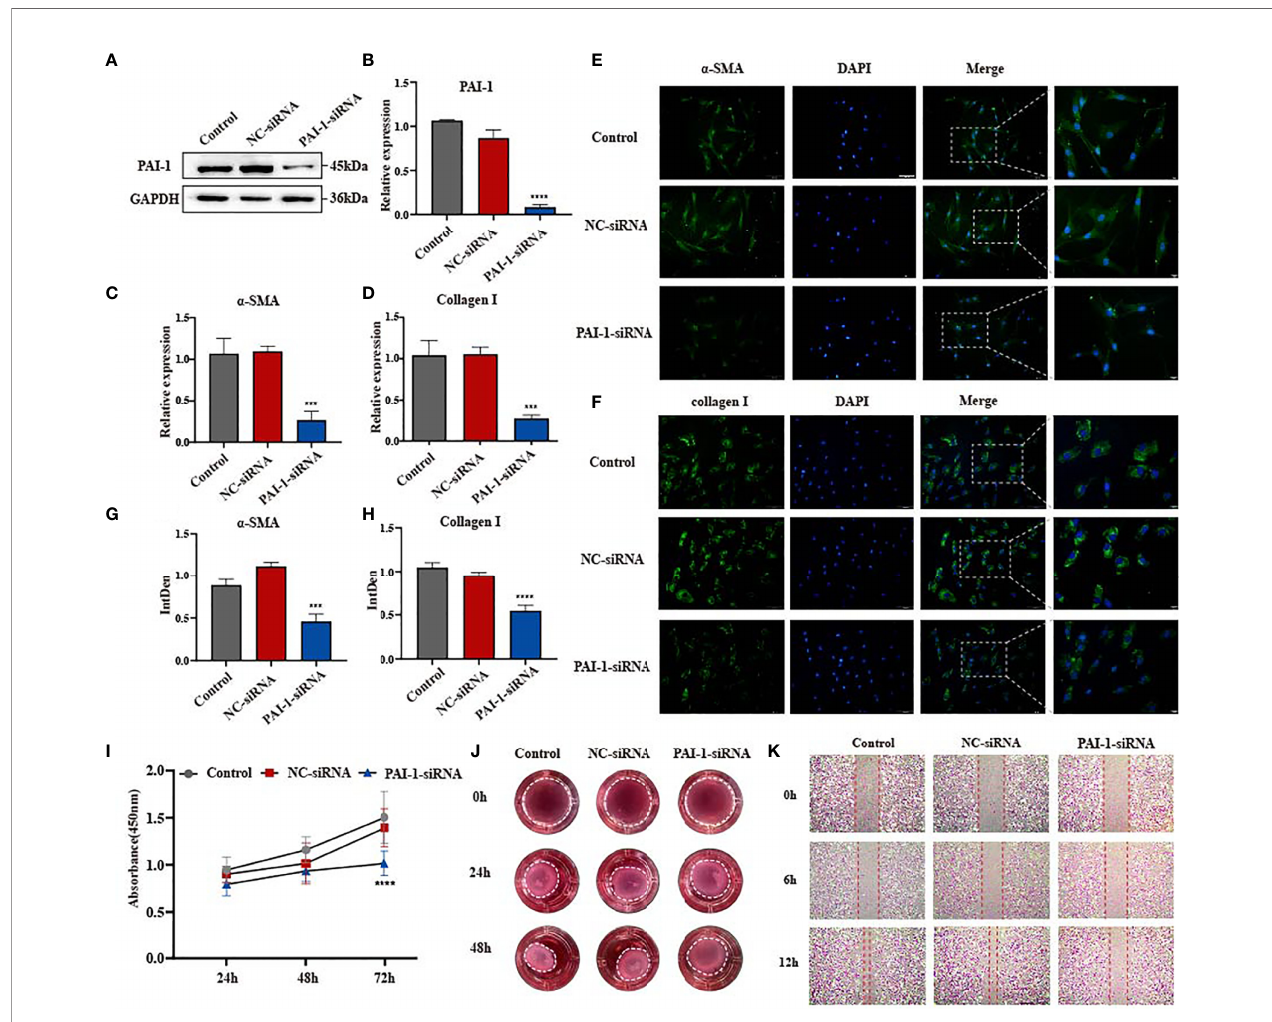
FIGURE 3 | Knockdown of PAI-1 inhibits fi brosis progression in vitro. (A, B) The knockdown ef fi ciency of PAI-1-siRNA in disease-derived fi broblasts was con fi rmed by western blot and qPCR. (C, D) mRNA level of a -SMA and type I collagen in three groups of cells. (E – H) Immuno fl uorescence staining of a -SMA and type I collagen in three groups of cells and their integrated density. scale bars, 100 m m, 20 m m. (I) The proliferation ability after knocking down PAI-1 was evaluated by the cell counting kit 8. (J) Effect of knocking down PAI-1 on the contractility of fi broblasts. (K) The migration ability of fi broblasts after knocking down PAI-1 was evaluated by wound-healing assay. ***P < 0.001, and ****P < 0.0001 when compared between the denoted